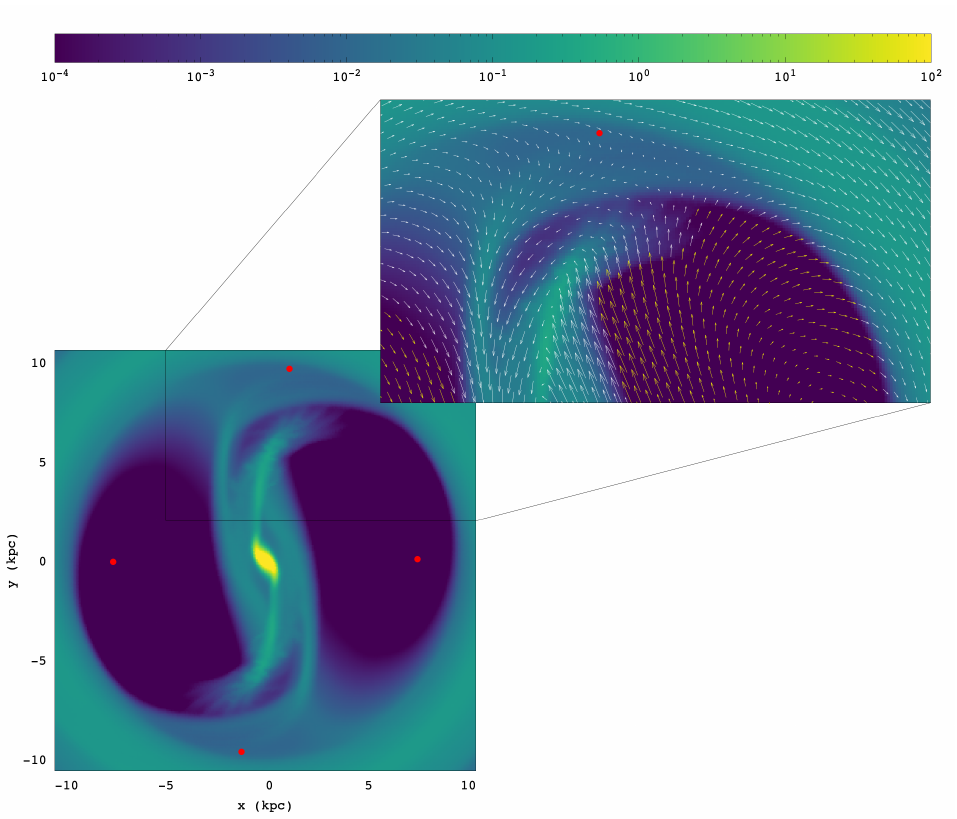
Figure 15. A mean RAMSES response morphology, created by stacking the images of 100 snapshots within 4.35 rotational periods of the system. It has all the typical morphological features discussed in the text. Red dots give the locations of the Lagrangian points.